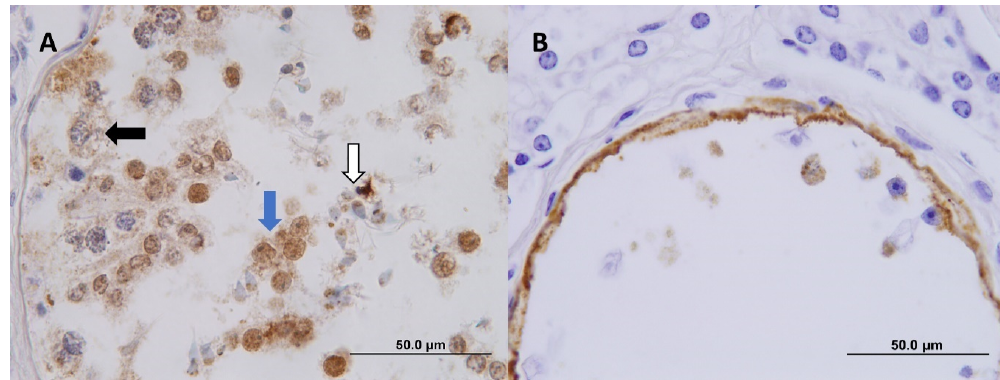
Figure 3. ( A ) A seminiferous tubule containing still-existing germinal cell stages in a BVDV-infected bovine testicle. BVDV staining is present in cells morphologically consistent with primary spermatocytes (black arrow), round spermatids (blue arrow) and elongated spermatids (white arrow). BVDV IHC, 100× (oil). ( B ) An atrophic seminiferous tubule in a BVDV-infected bovine testicle. The tubular luminal surface has intense BVDV staining which appears to occasionally extend into the superficial tubular mesenchyme and within degenerate free intraluminal cells. BVDV IHC, 100× (oil).